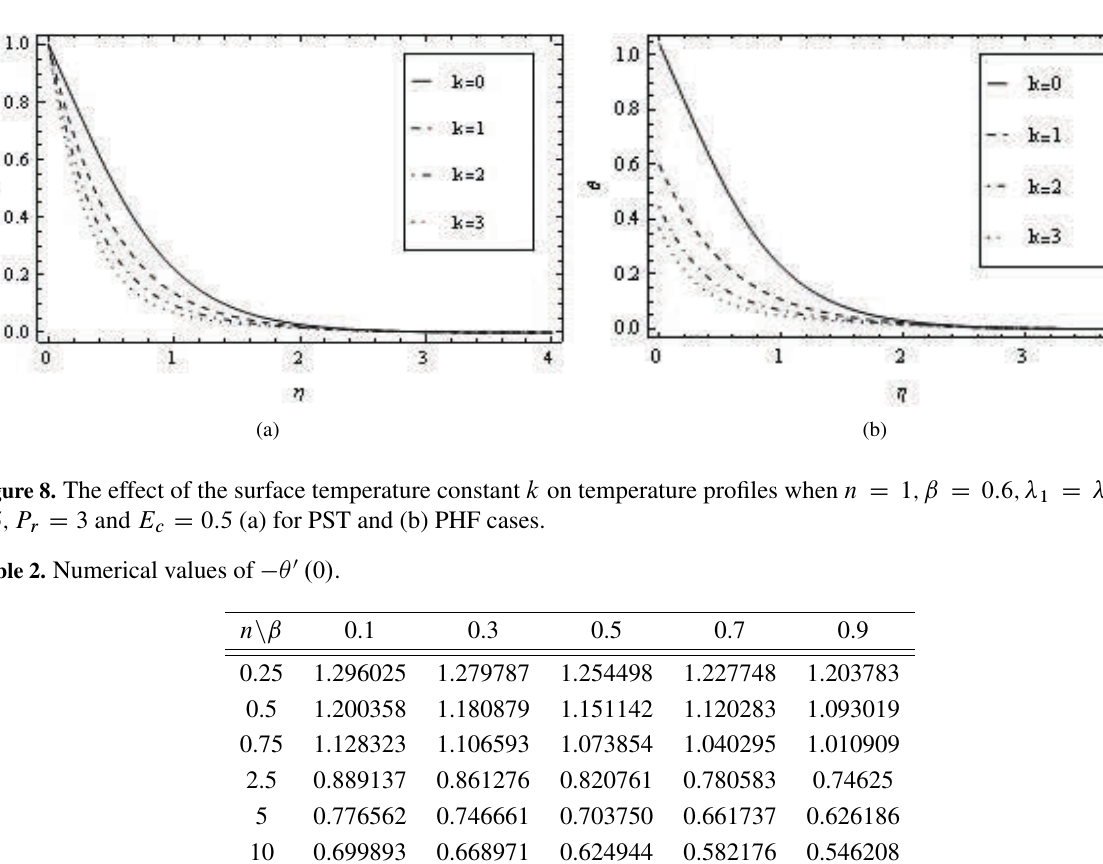
Figure 7. The effect of non linear stretching sheet parameter n on temperature profiles when E c D :5; ˇ D 0:6; (cid:21) 1 D (cid:21) 2 D 0:5; P r D 3 and k D 1:5 (a) for PST and (b) PHF cases.